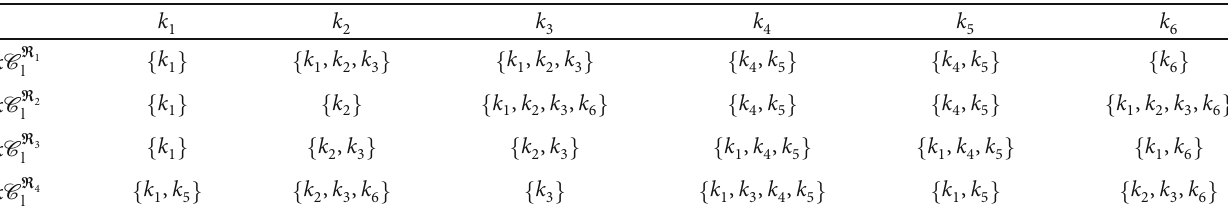
Table 5: Table for house assessment